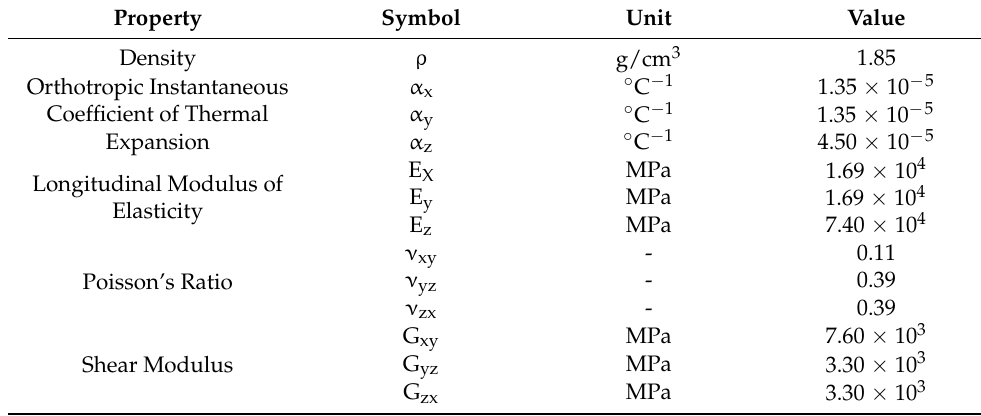
Table 1. The physical and elastic properties of FR4 material.